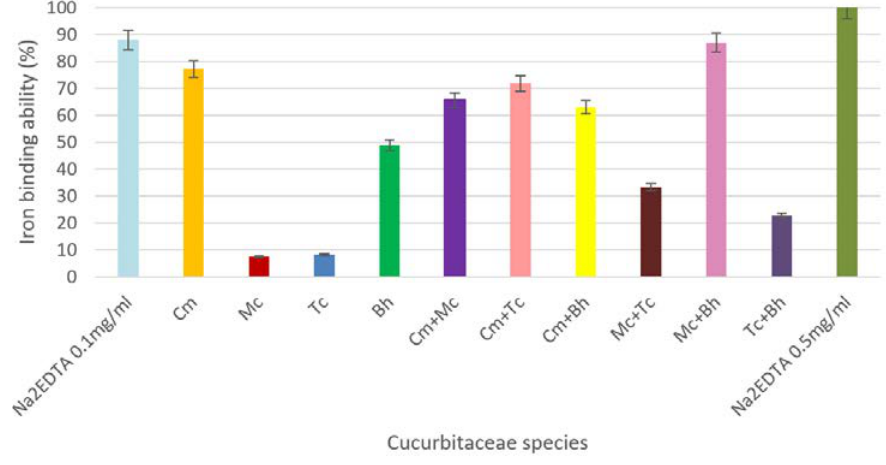
Figure 7. Iron binding ability of the samples; where Cm- C. metuliferus, Tc- T. cucumerina , Mc- M. charantia, Bh- B. hispida. The error bars represent ± standard deviation of three replicates.